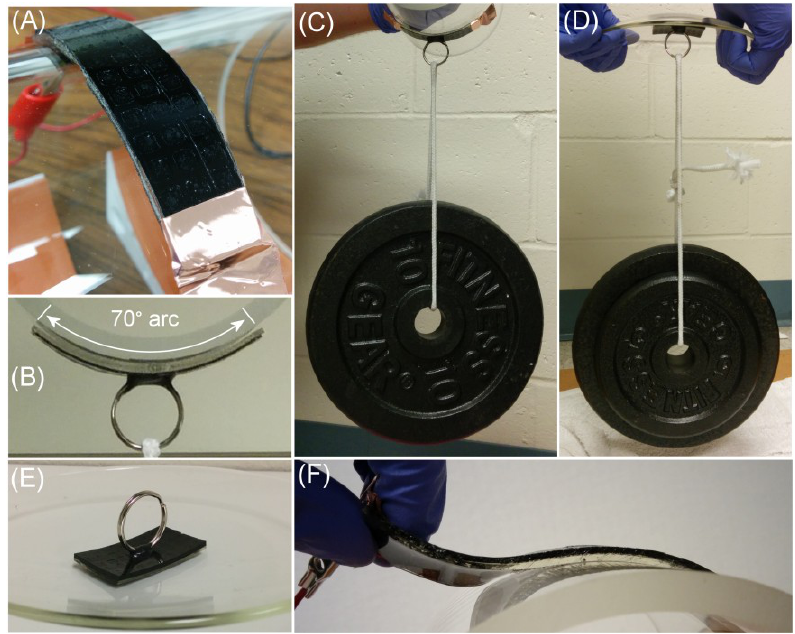
Figure 7. ( A ) An adhesive strip is internally heated and bonded to a curved glass surface covering a 70° arc ( B ); ( C ) The bonded strip supports a 10 lb weight; ( D ) A bonded strip supports 15 lbs on a concave glass surface, shown in greater detail in ( E ); and ( F ) Heating the bonded strip allows for easy peel removal.